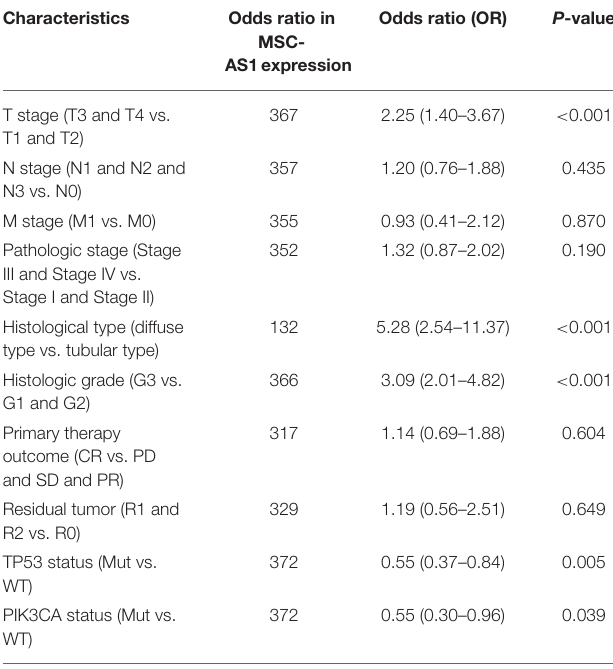
TABLE 2 | Association of lncRNA MSC-AS1 expression with clinical pathological characteristics by logistic regression.